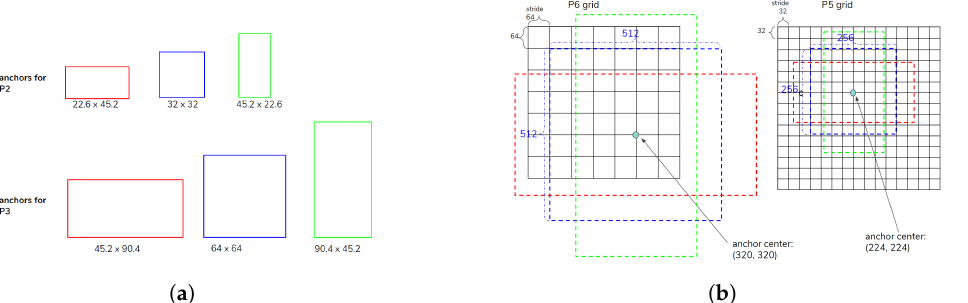
Figure 8. Illustration of ( a ) anchors in different sizes, ratios (Anchors in three scales and ratios) and ( b ) placing anchors on feature maps